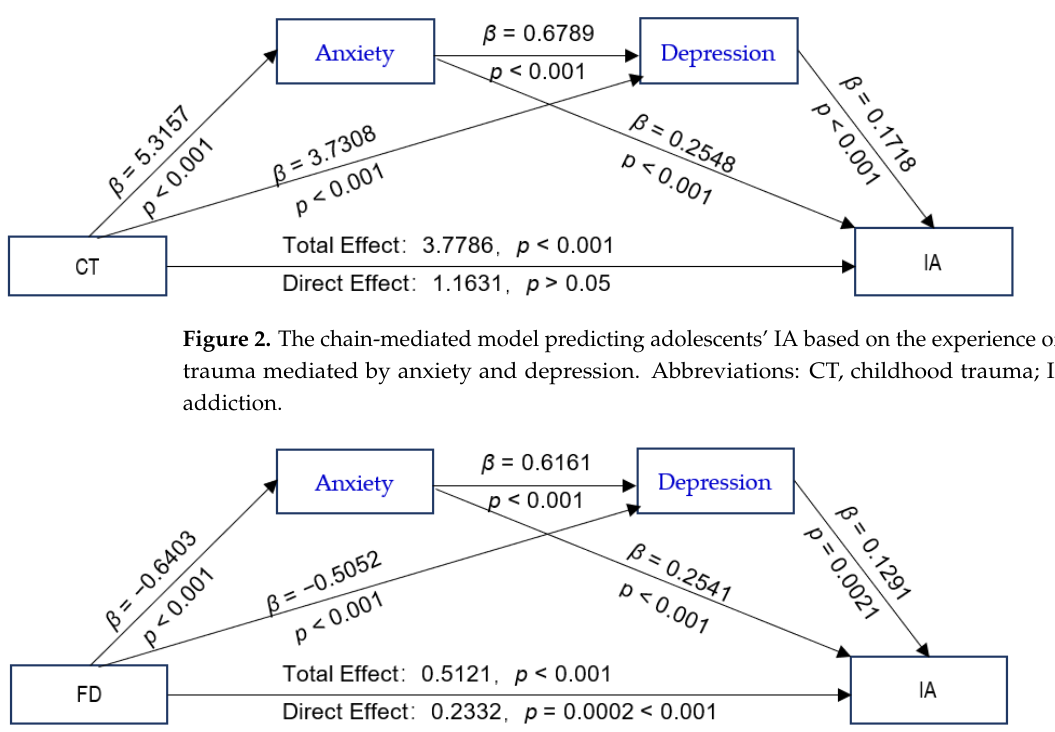
Figure 3. The chain-mediated model predicting adolescents’ Internet addiction based on family dysfunction mediated by anxiety and depression. Abbreviations: FD, family dysfunction; IA, Internet addiction.